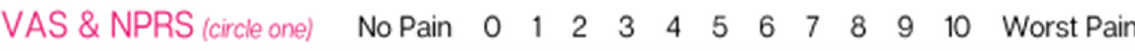
Figure 1. Numeric Pain Rating Scale used by patients to assess pain level.